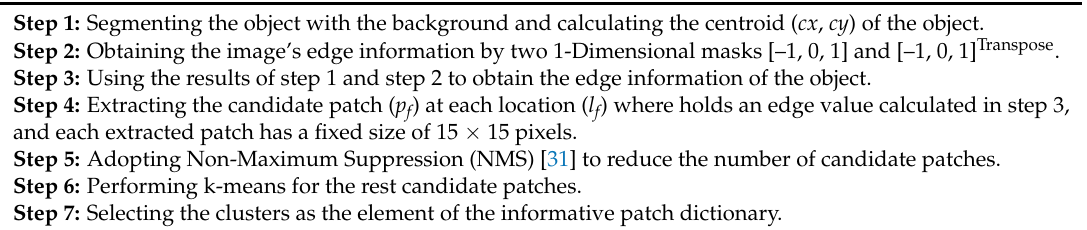
Table 1. The process of building the informative feature